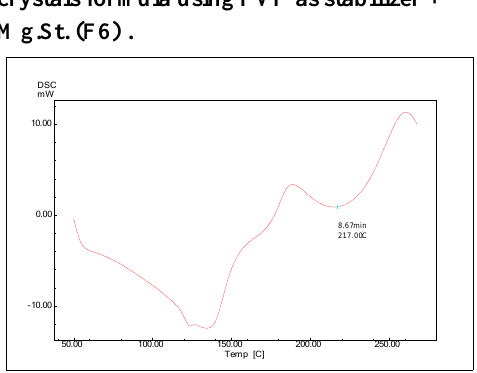
Figure 10: DSC curve cefixime and PVP (1:1) physical